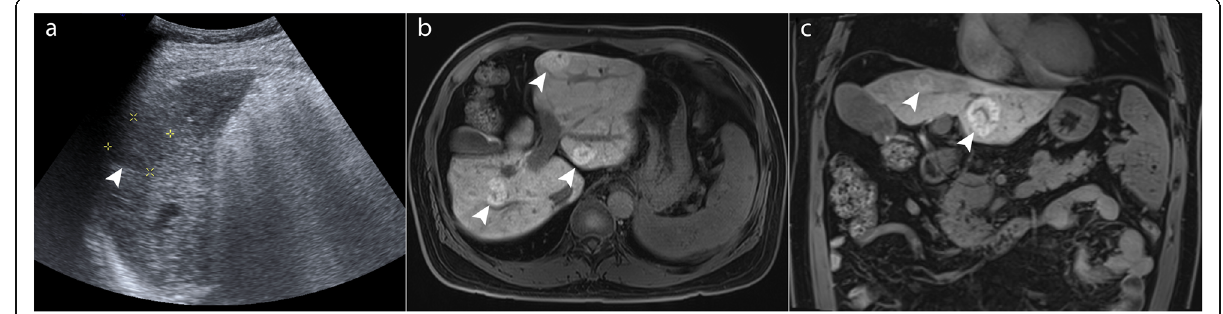
Fig. 2 A 59-year-old patient with chronic hepatitis B and cirrhosis who has at least 10 hypoechoic lesions on US ( a ) measuring 2 – 3 cm (arrowhead). On gadoxetic acid-enhanced magnetic resonance imaging ( b , c ), these are shown to be focal nodular hyperplasia (FNH)-like nodules in cirrhosis (arrowheads). This patient cannot be reliably screened with ultrasound. In fact, FNH-like nodules are identical to classic FNH and are benign. They occur in cirrhosis and are believed to originate from acquired hyperplastic responses to vascular alterations associated with